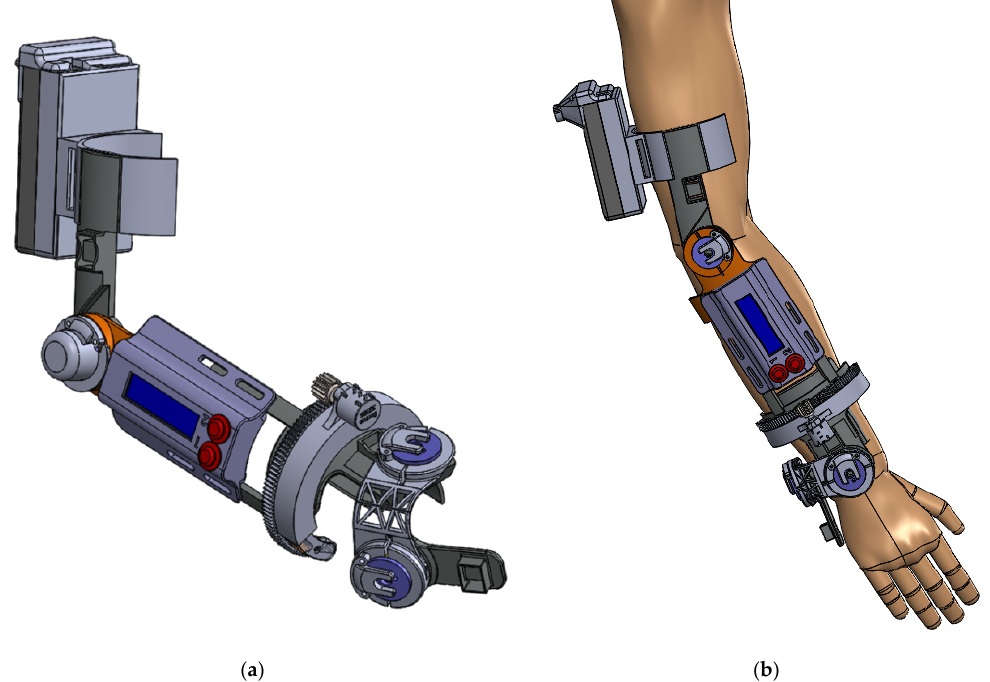
Figure 4. ( a ) 3D Modelling of the final prototype assembly, ( b ) Protoype mounted on the arm of a